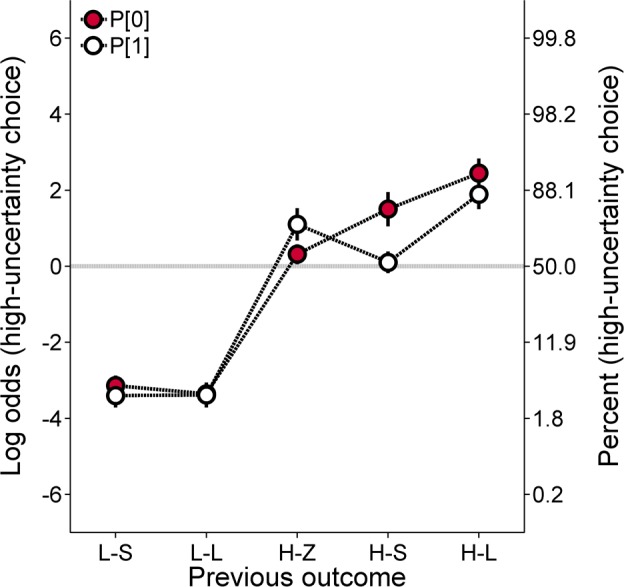
Mean (±SEM) log odds of high-uncertainty choices collapsed across groups in the high-uncertainty probability training procedure of Experiment 3A as a function of the outcome of the previous choice, collapsed across probability.A second ordinate showing percentages corresponding to the log odds values was included to aid interpretation. L-S = low-uncertainty-small; L-L = low-uncertainty-large; H-Z = high-uncertainty-zero; H-S = high-uncertainty-small; H-L = high-uncertainty-large; P[0] = probability of 0 pellets; p[1] = probability of 1 pellet.